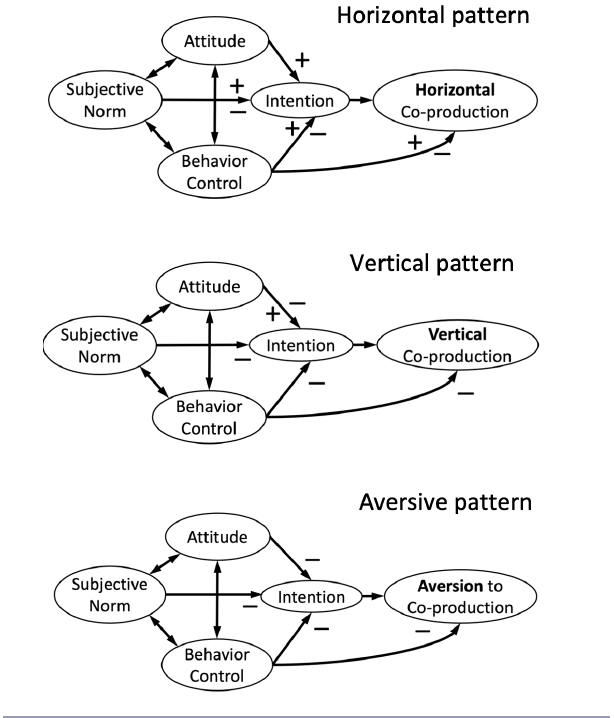
Fig. 3 . Identified patterns of researchers’ behavioral intentions towards co-production according to TPB Determinants